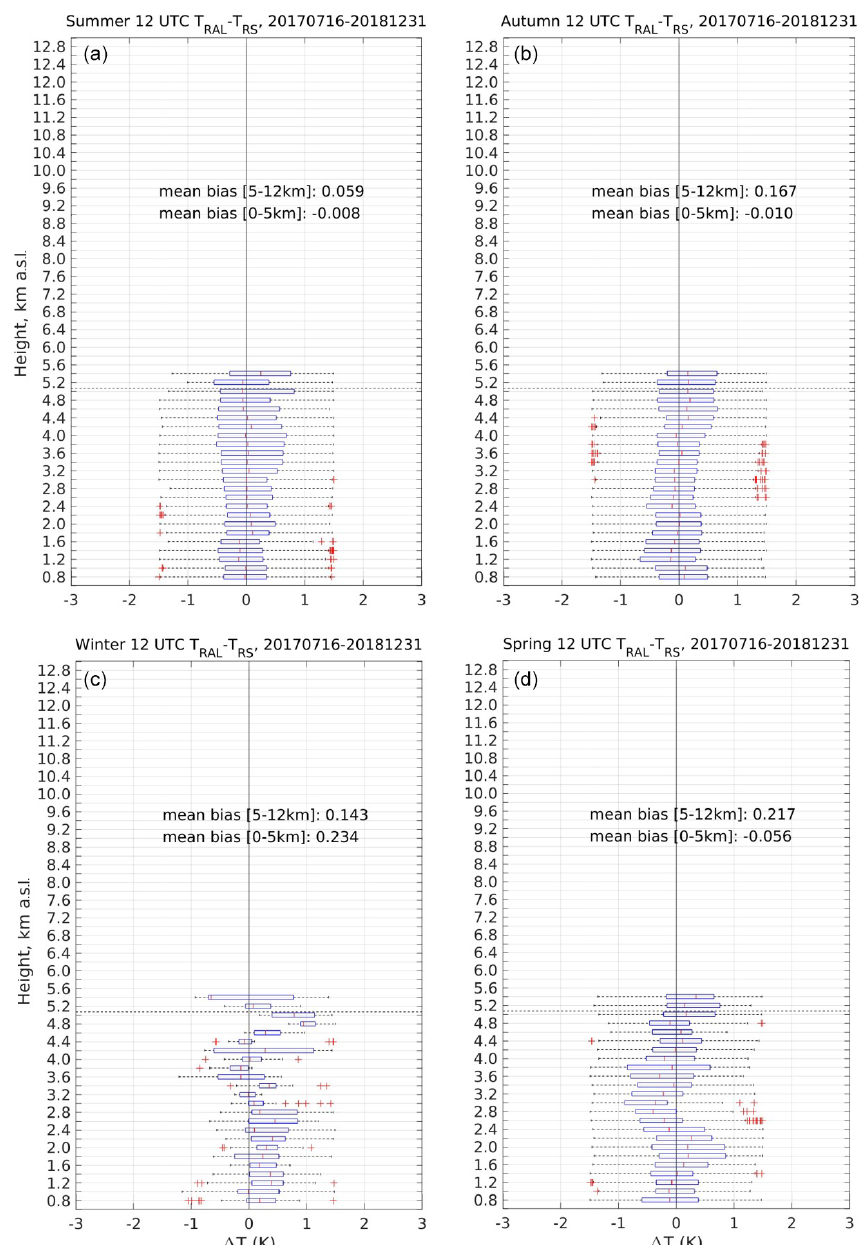
Figure 13. Seasonal daytime bias of (cid:49)T over the period July 2017–December 2018. The boxplot characteristics are the same as in Figs. 10 and 11 but restricted over the seasonal periods. Based on the definition of seasons provided in the text, in clockwise order starting form the upper-left corner, panel (a) shows the summer data, panel (b) shows the autumn data, panel (c) shows the winter data and panel (d) shows the spring